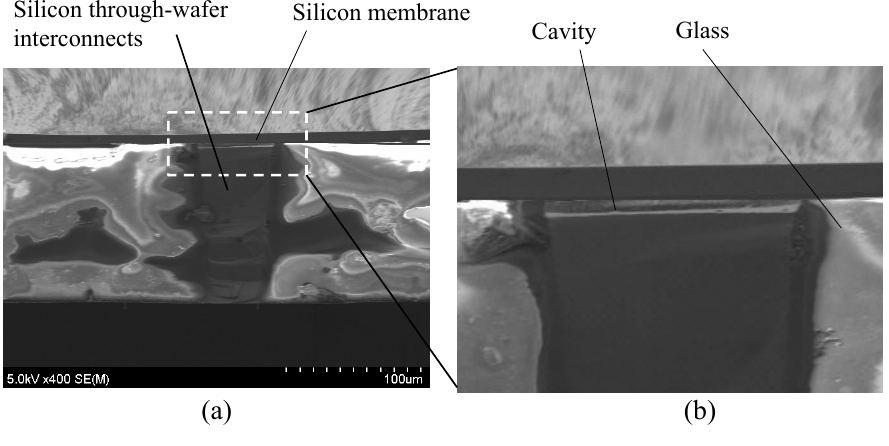
Figure 5. ( a ) Vacuum cavity; ( b ) Close-up image.